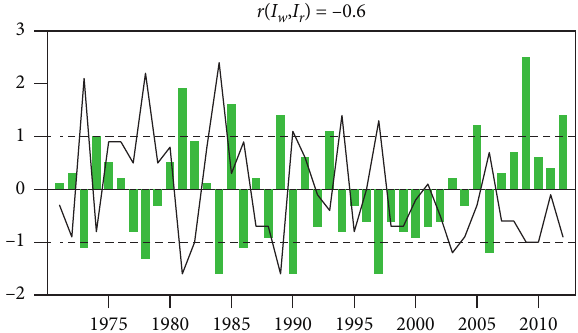
Figure 6: Normalized time series of the I (green bars). Figure 5: Simultaneous correlation between I r and the zonal winds